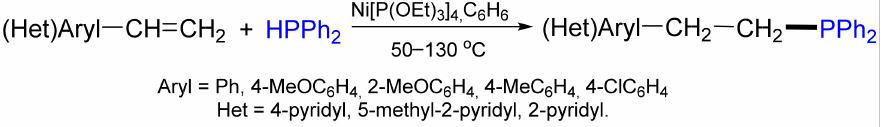
Figure 12. Hydrophosphination of weakly activated olefins and their heterocycle-containing